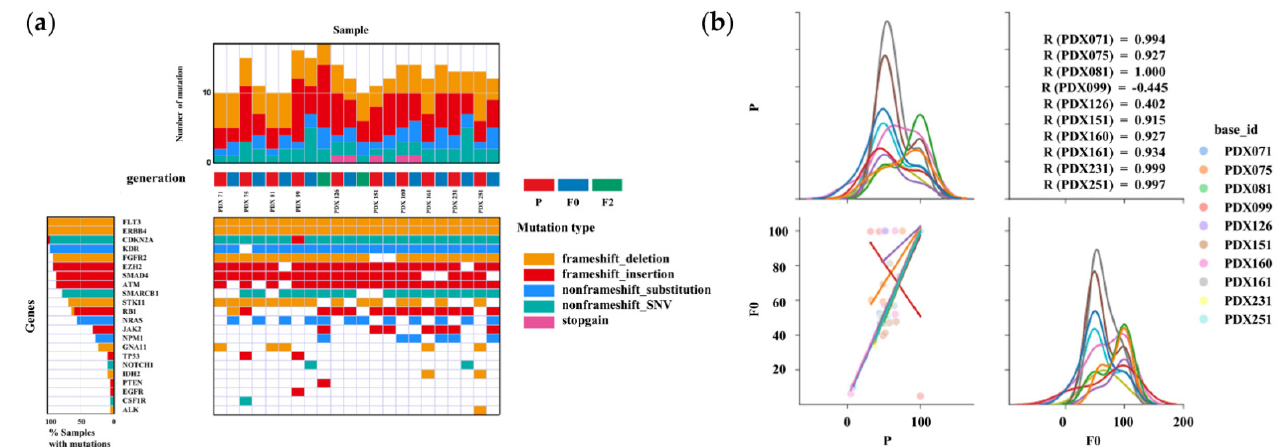
Figure 4. Summary of the relationships between somatic mutations in primary and PDX tumors based on DNA-seq results. ( a ) Heatmap analysis of the DNA profiling in tissues of the PDX and primary tumors using the AmpliSeq Cancer Hotspot Panel v 2. In all cases, gene mutations in primary (P) and PDX (F0 and F2) tumors were found to be highly correlated. ( b ) Variant allele frequencies (VAFs) of somatic mutations identified in P and F0 tumors. The lower-left graph shows a scatter plot and linear regression of the VAF levels in the P and F0 tumors. The diagonal graph shows the kernel density estimation (KDE). In most cases, P and F0 tumors show a high correlation whereas PDX99 tumor show a low correlation.